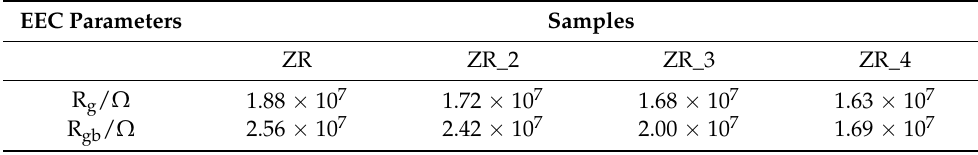
Table 3. Selected EEC parameters obtained from fitting data given in Figure 5b. EEC